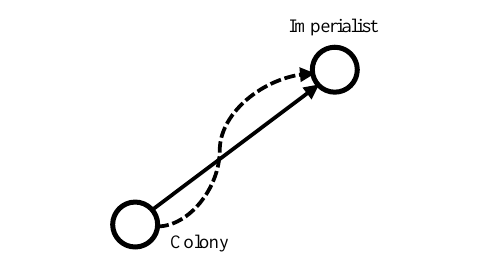
Figure 3. Movement of a colony toward its